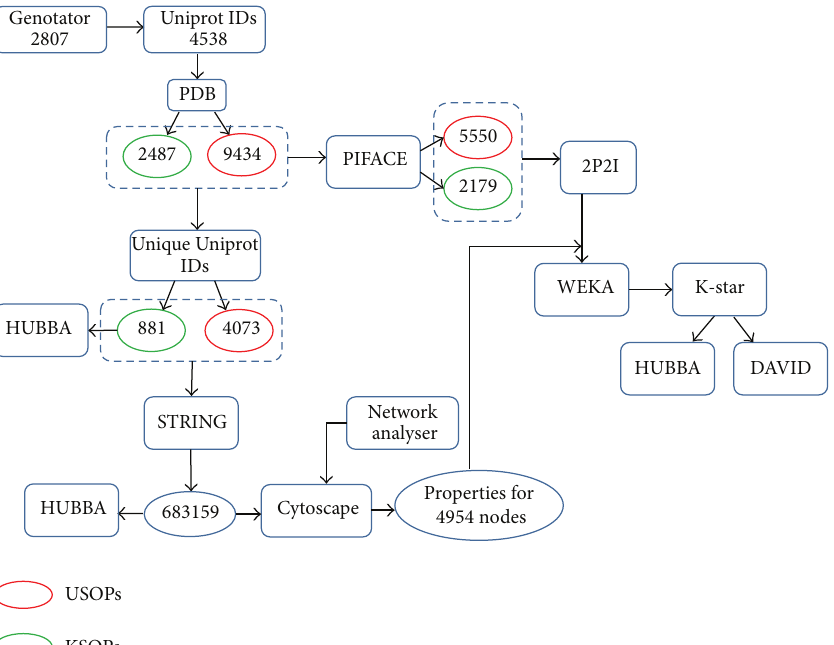
Figure 1: Flowchart of the methodology followed. KSOPs is the known set of proteins, and USOPs is the unknown set of proteins.